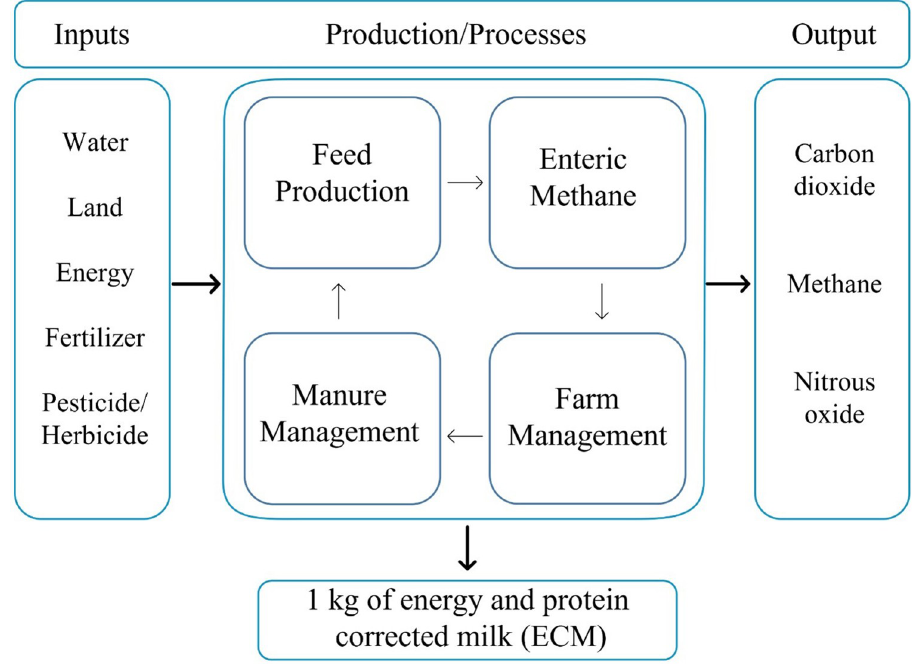
Fig 1. Overview of the milk production system boundary considered in this